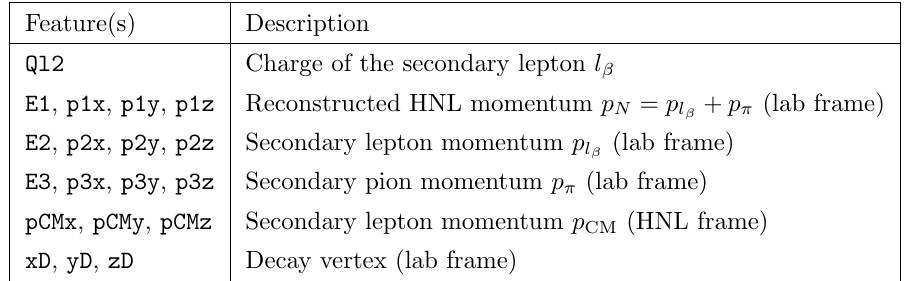
Table 1. The 19 features recorded for each